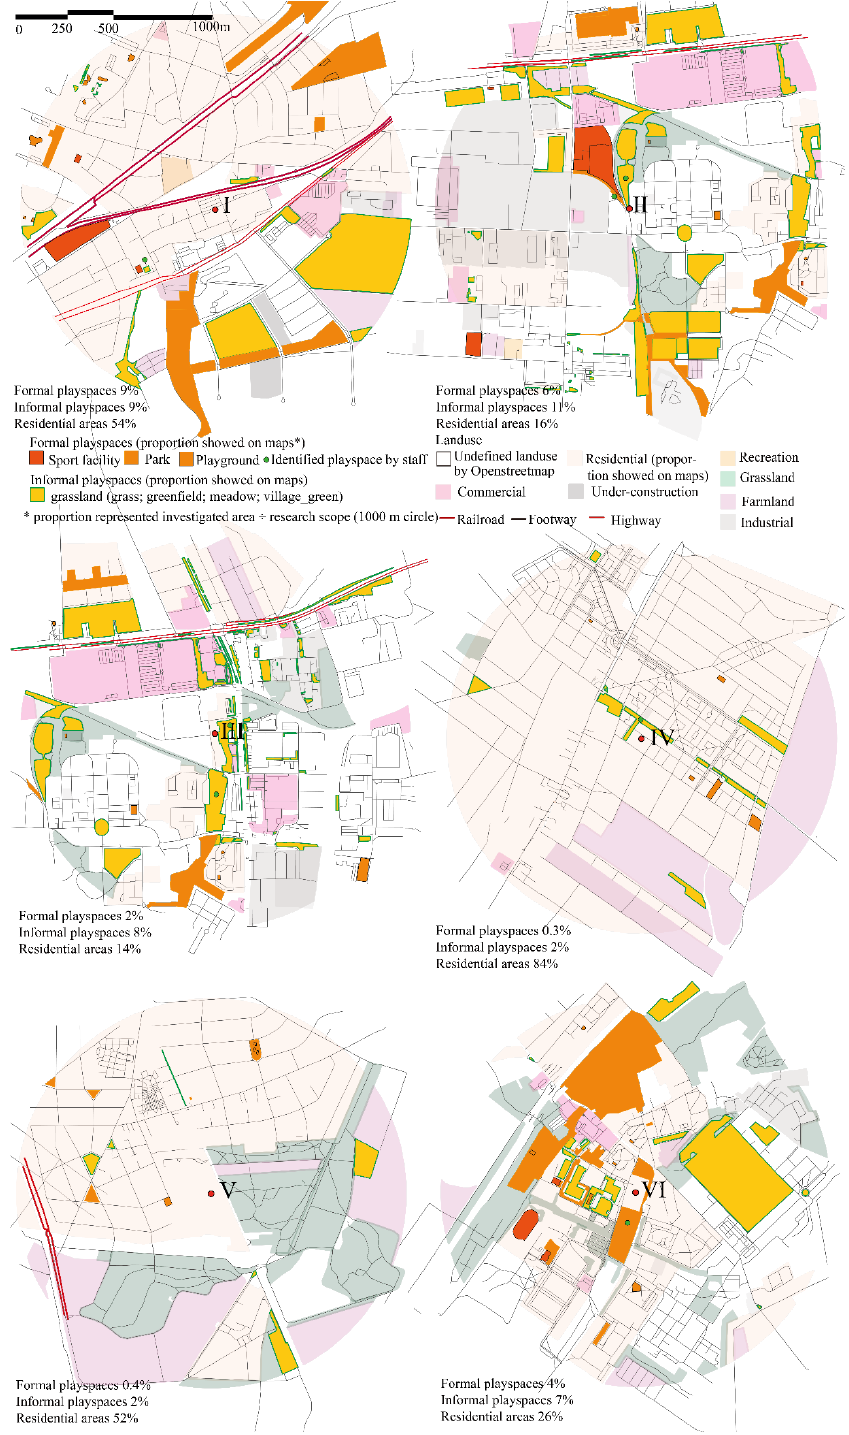
Figure 6. Potential playspaces and land use of six study sites.